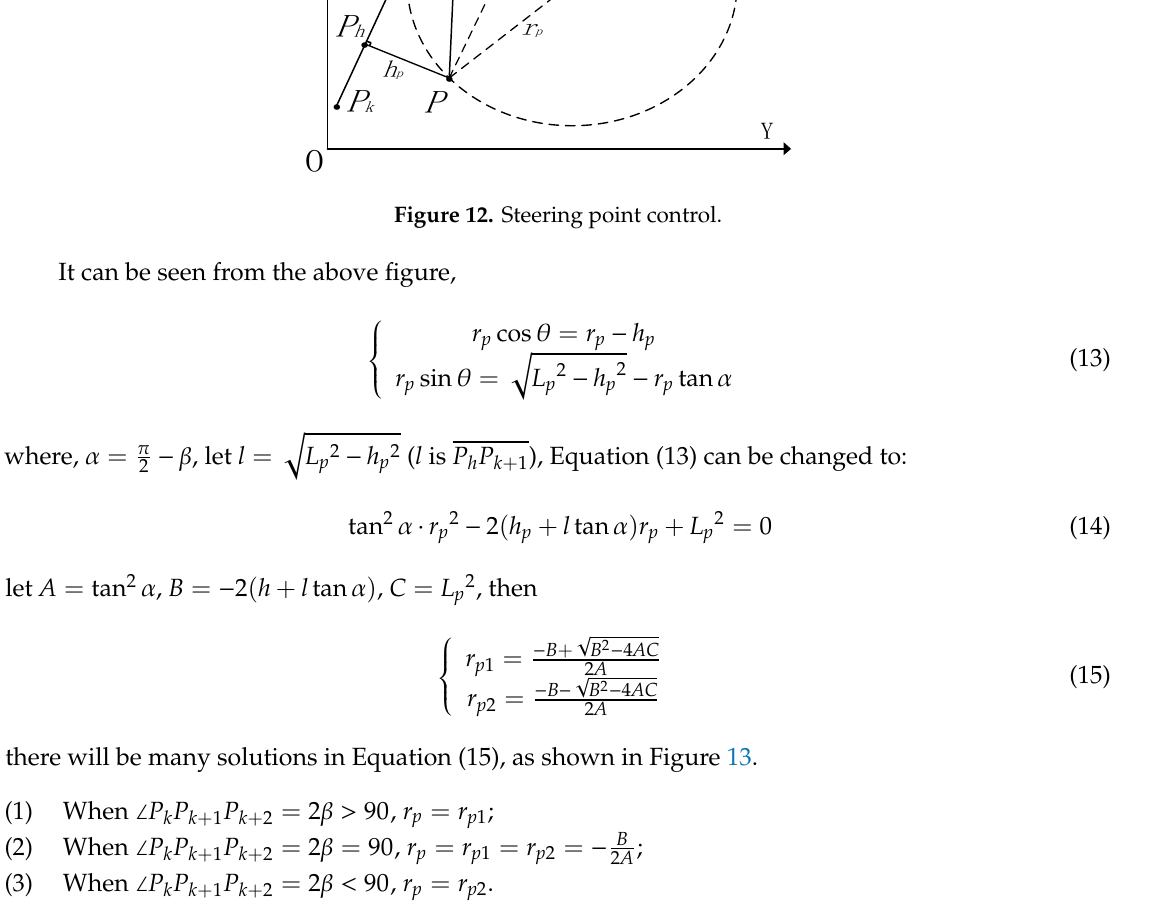
Figure 13. Multi solution problem of turning point control.